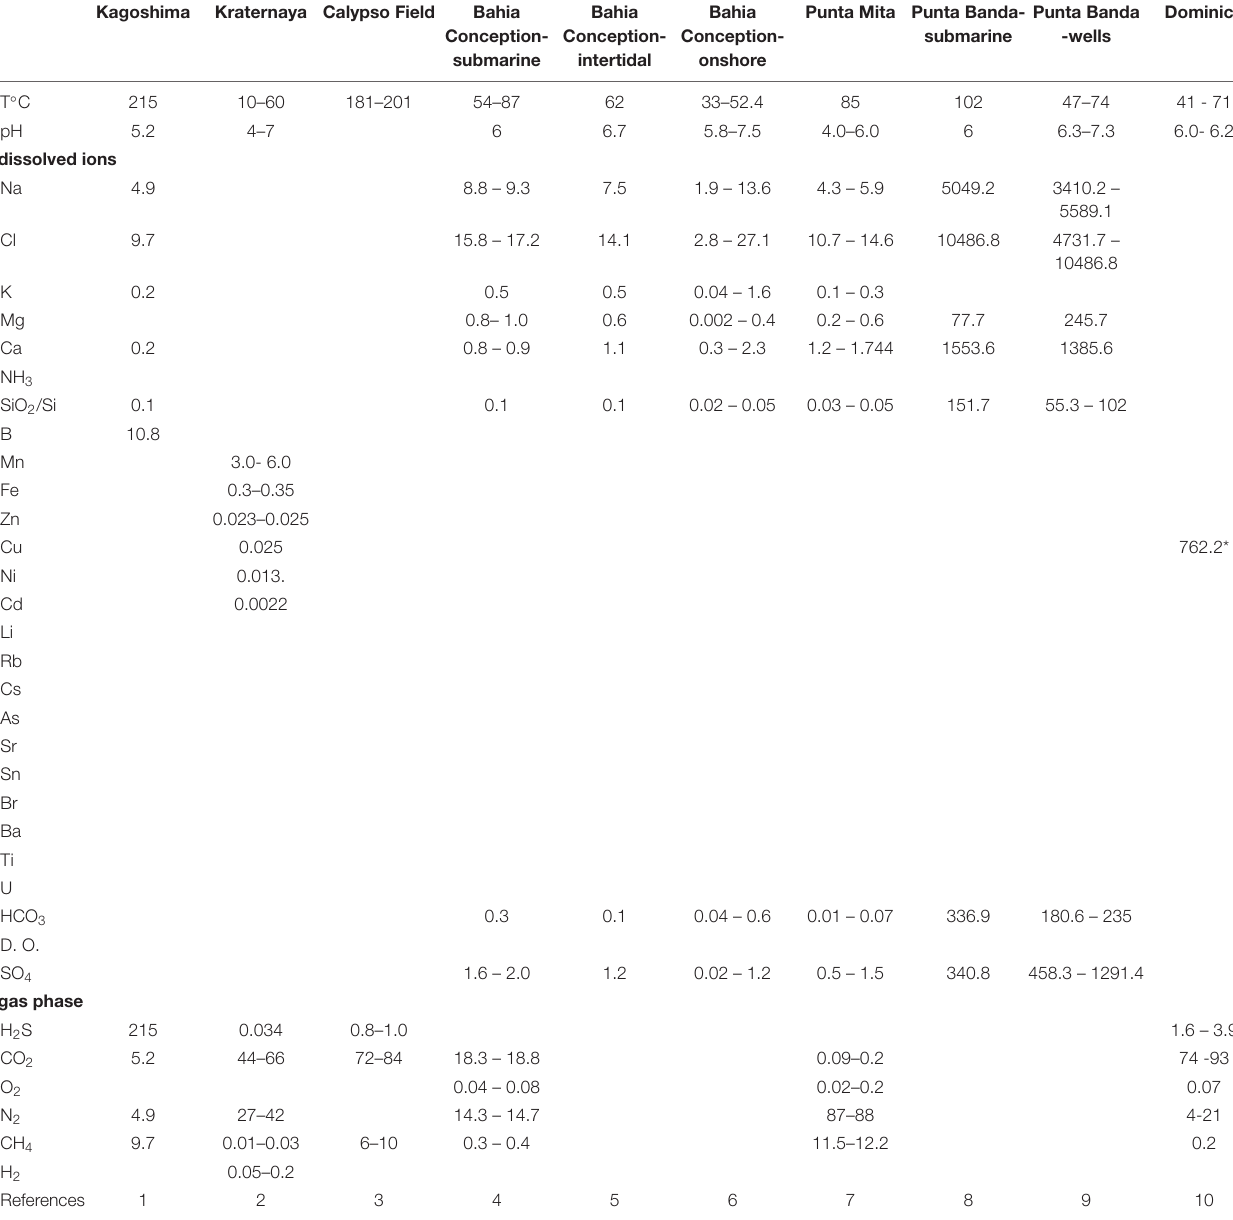
TABLE 1b | Main physical parameters and chemical composition of the emitted fluids (in ppm, Ba in ppb) and gases (in%) from Kagoshima, Kraternaya, Calypso, Bahia Conception, Punta Mita and Punta Banda, as well as